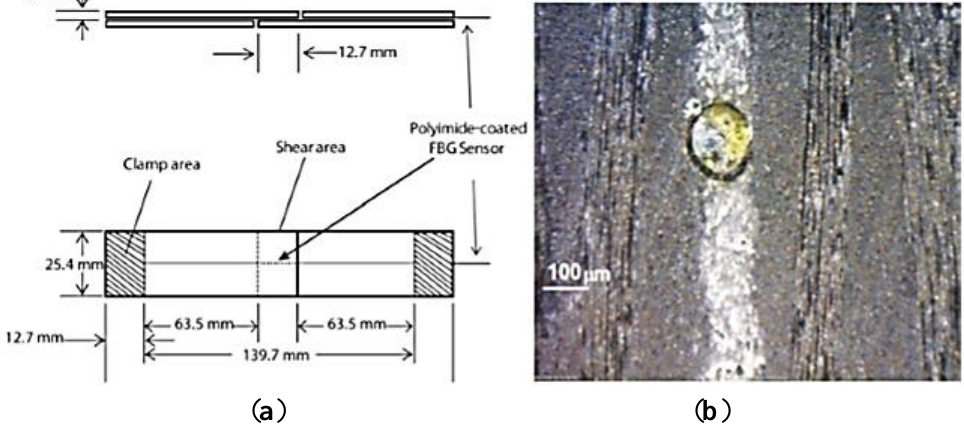
Figure 14. ( a ) Specimen with composite lap joint and embedded optical fiber; ( b ) micrograph of an embedded FBG sensor